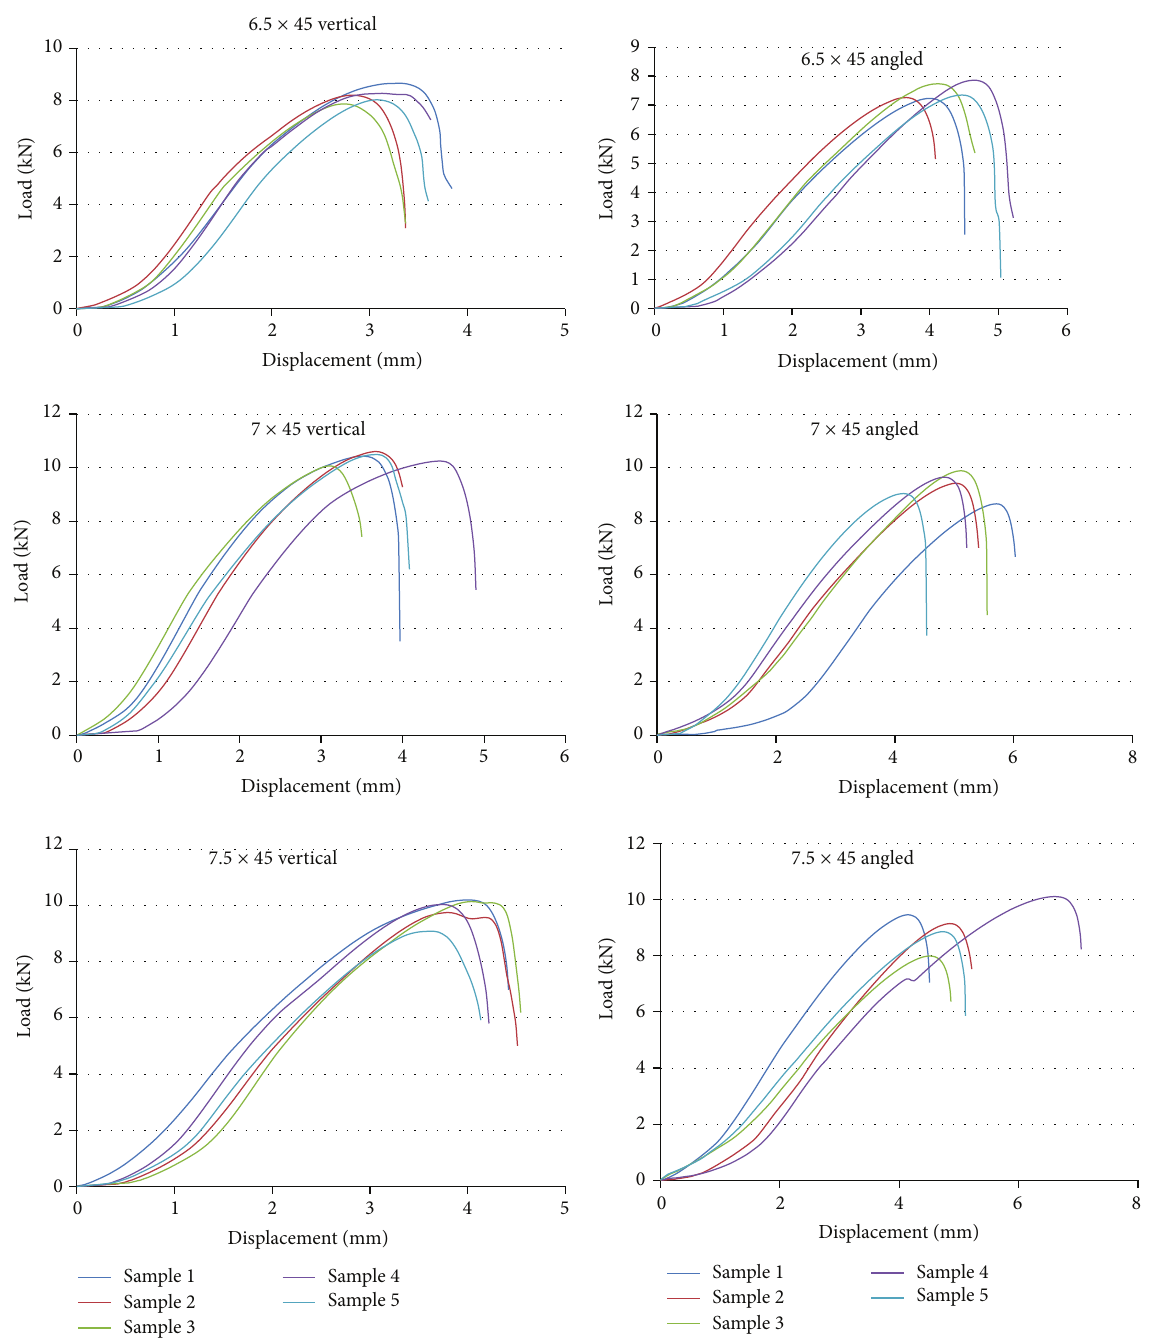
Figure 4: Load versus displacement curves of the vertical and angled